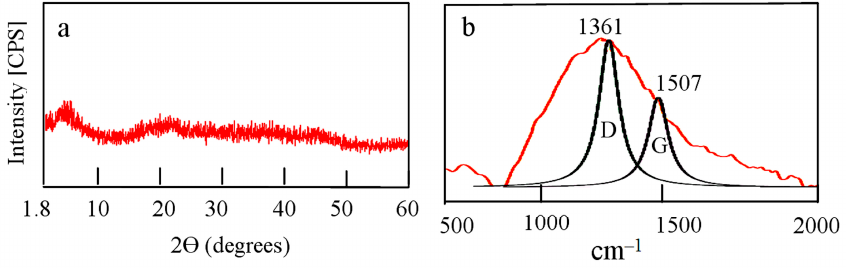
Figure 7. The prepared nanocomposite NC-3: ( a ) X-ray diffraction and ( b ) Raman spectrum.